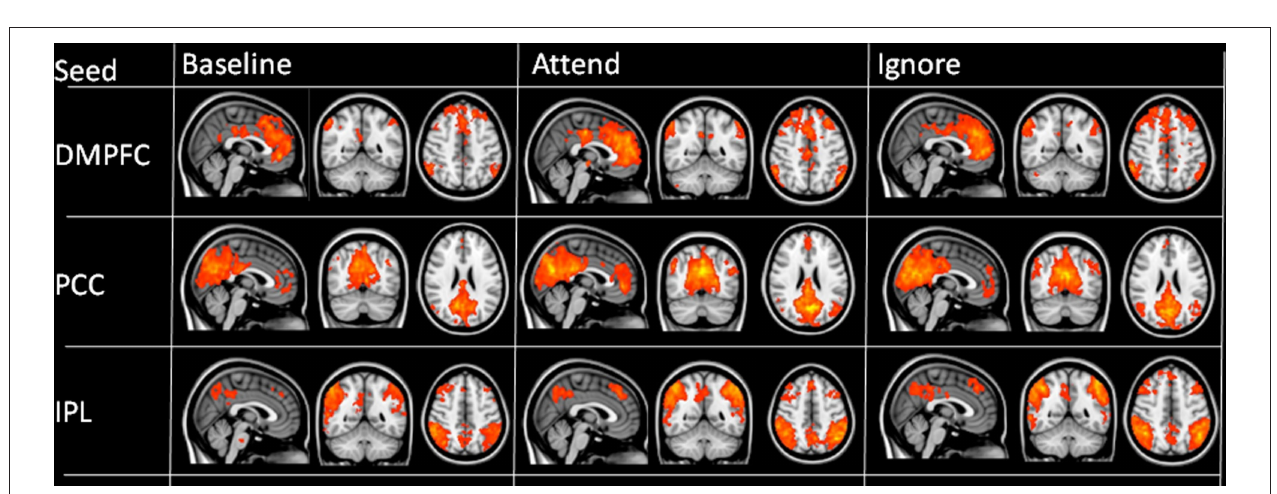
FIguRe 4 | Results of ROI analysis using clinical DMN ROIs. Weighted contrast parameter estimates were extracted from three contrasts ([ignore > attend], [attend > baseline], [ignore > baseline]) and entered into a one-sample t -test. * p < 0.006, ** p <